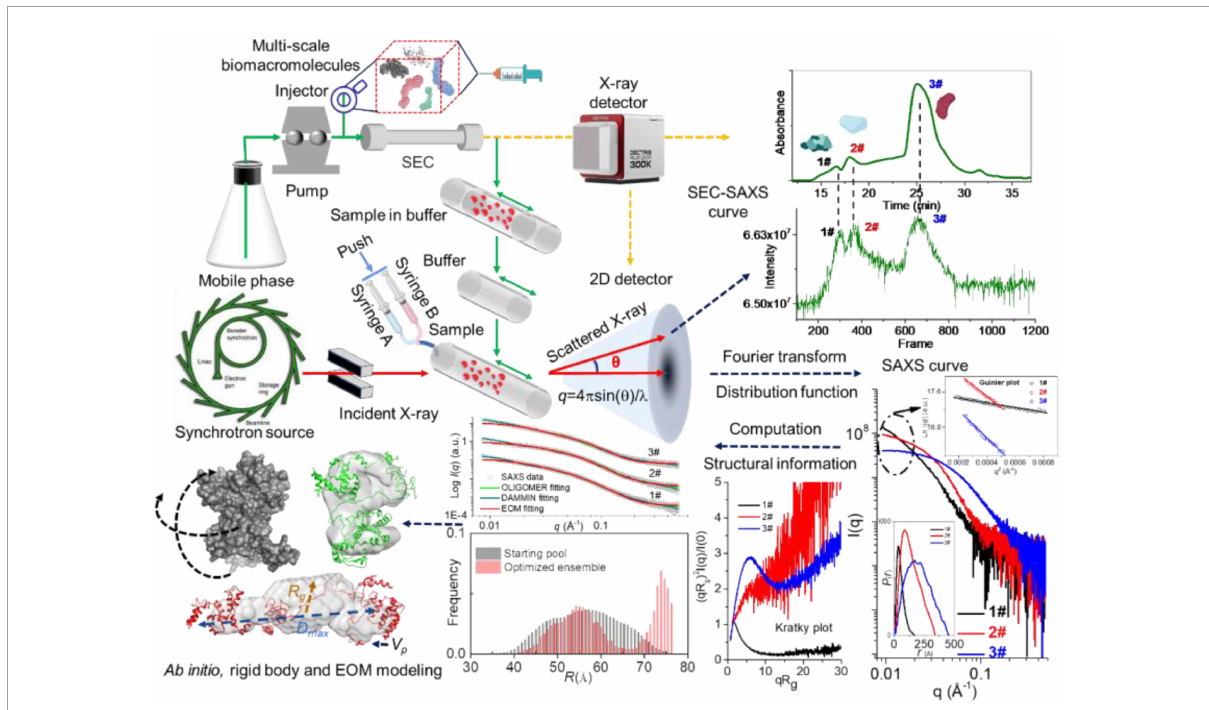
FIGURE1 Principle, a typical small-angle X-ray scattering (SAXS) experiment and derivative profiles. Reproduced from Sun et al. (29) (Copyright 2021 Elsevier Publisher).